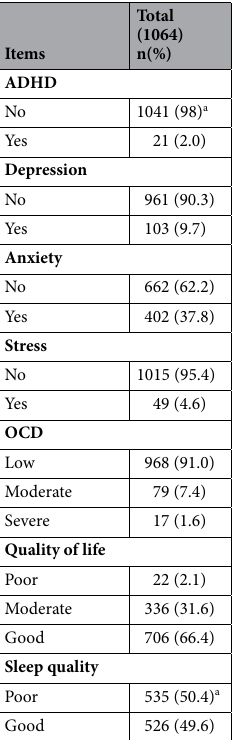
Table 4. Three latent class model of quality of life, sleep quality and common mental disorders among Iranian older adults. Item-response probabilities > .5 in bold to facilitate interpretation.